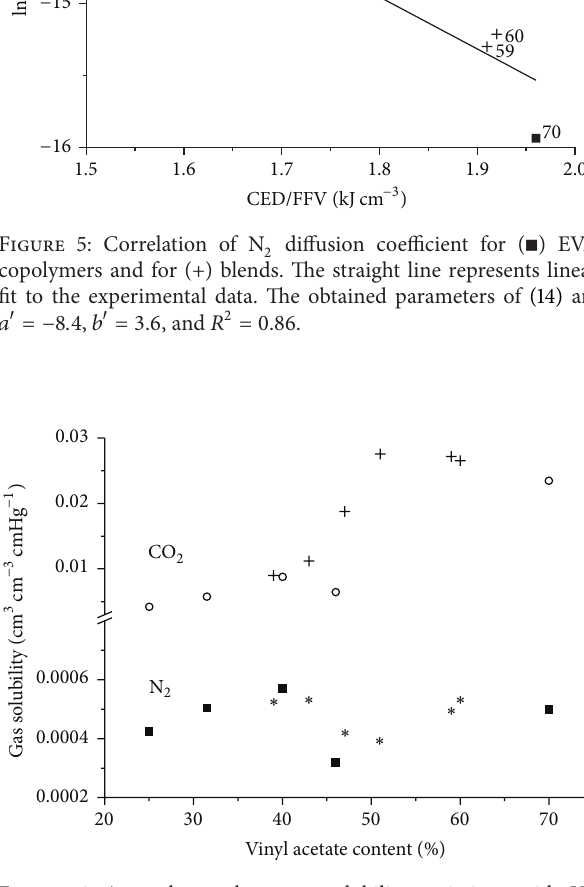
Figure 6: Amorphous phase gas solubility variations with VA content in EVA copolymers ( ∘ , ◼ ) and EVA copolymer blends (+, ∗ ). Note that different scales below and above break on the vertical axis were